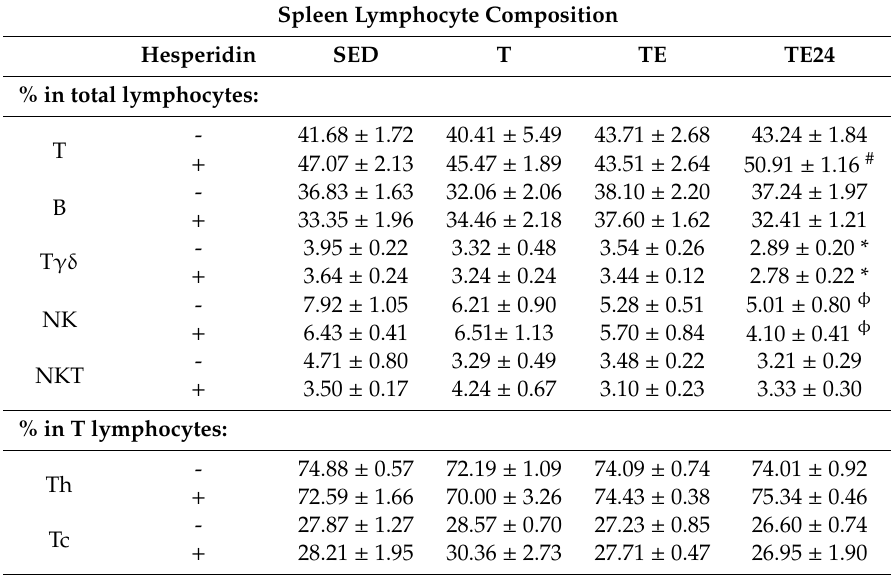
Table 2. Percentages of spleen lymphocytes: T (TCR αβ + ); B (CD45RA + ); T γδ (TCR γδ + ); NK (CD161b + );